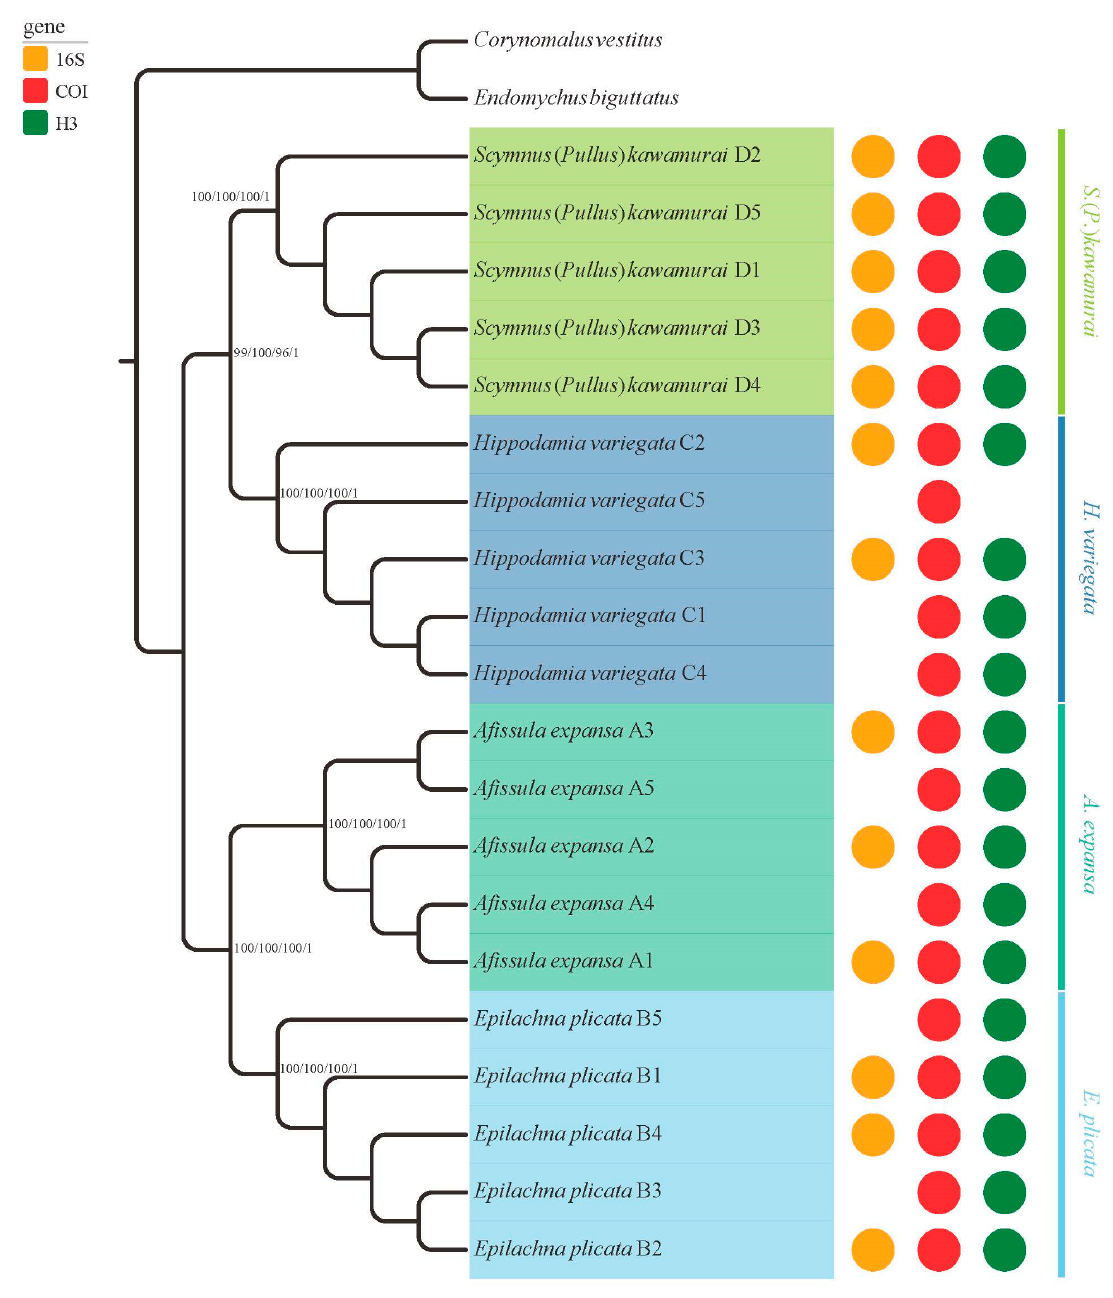
Figure 3. Cladogram derived from analyses of the three markers demonstrating the phylogenetic relationships based on neighbor-joining (NJ), maximum parsimony (MP), maximum likelihood (ML), and Bayesian inference (BI) of the combined dataset (1680 bp) under partition strategies. The support rate of the branches from left to right represents bootstrap values for NJ analysis, bootstrap values for MP analysis, bootstrap values for ML analysis, and posterior probabilities for BI. The codes following the sample name in this figure correspond to the code in Table 1. The vacant part of the circle on the right side of the tree represents target genes that we failed to amplify or sequence.